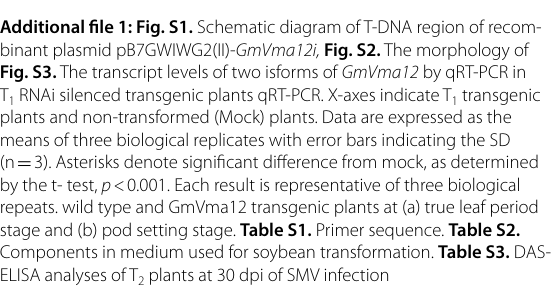
Fig. S3. The transcript levels of two isforms of GmVma12 by qRT-PCR in T 1 RNAi silenced transgenic plants qRT-PCR. X-axes indicate T 1 transgenic plants and non-transformed (Mock) plants. Data are expressed as the means of three biological replicates with error bars indicating the SD (n 3). Asterisks denote significant difference from mock, as determined = by the t- test, p < 0.001. Each result is representative of three biological repeats. wild type and GmVma12 transgenic plants at (a) true leaf period stage and (b) pod setting stage. Table S1. Primer sequence. Table